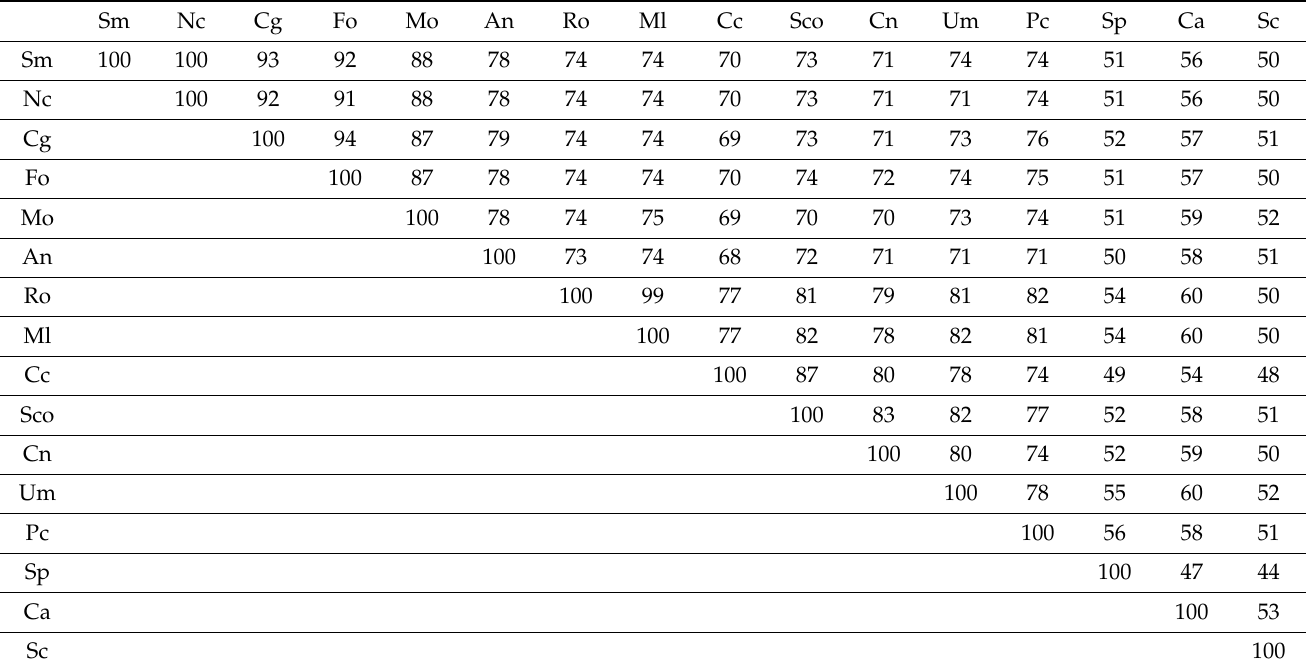
Abbreviations: Sm, Sordaria macrospora ; Nc, Neurospora crassa ; Cg, Colletotricum graminicola ; Fo, Fusarium oxysporum f. sp. Lycopersici ; Mo, Magnaporthe oryzae ; An, Aspergillus nidulans ; Sc, Saccharomyces cerevisiae ; Ca, Candida albicans ; Pc, Pneumocystis carinii , Sp, Schizzosaccharomyces pombe ; Cn, Cryptococcus neoformans var. grubii ; Um, Ustilago maydis ; Cc, Coprinopsis cinerea ; Sco, Schizophyllum commune ; Ro, Rhizopus oryzae ; Ml, Mucor lusitanicus